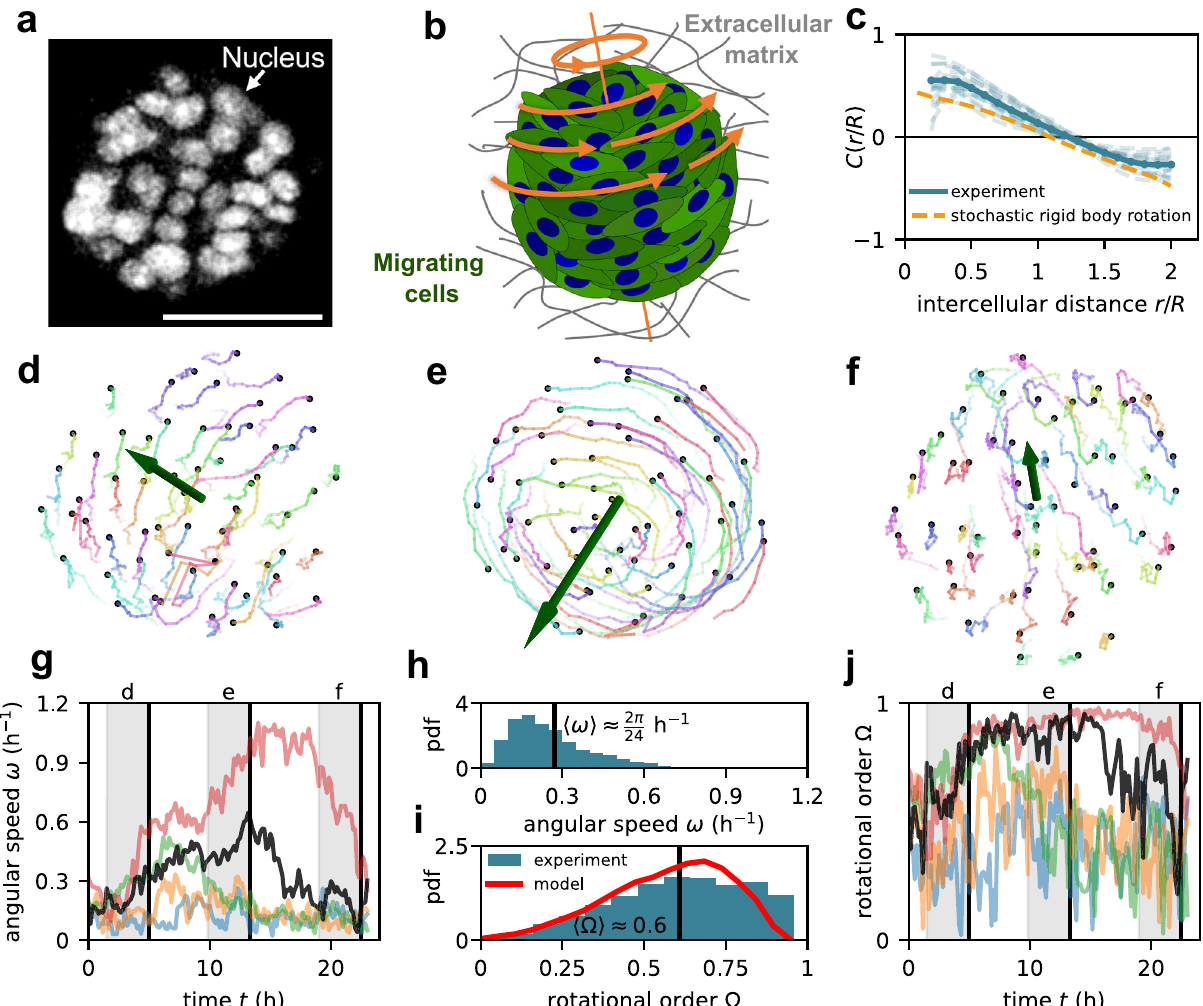
Fig. 1 | Stochastic global rotations of spheroids. a Fluorescence microscopy imageofaspheroidwith fl uorescentlylabeled(GFP-NLS)nuclei(seethe “ Methods ” section). Scale bar 50 μ m. b Sketch of a rotating spheroid in its extracellular environment. c Spatialcorrelationfunctionofvelocitydirections C ð r = R Þ ,where r is the distance between two cells throughout the spheroids and R is the spheroid radius (see the “ Methods ” section). Experimental curves for individual spheroids (light blue) and their average (blue) are compared with the correlations of a sto- chastic rigid-body rotation (orange) (Supplementary Section 2). d – f Time series of